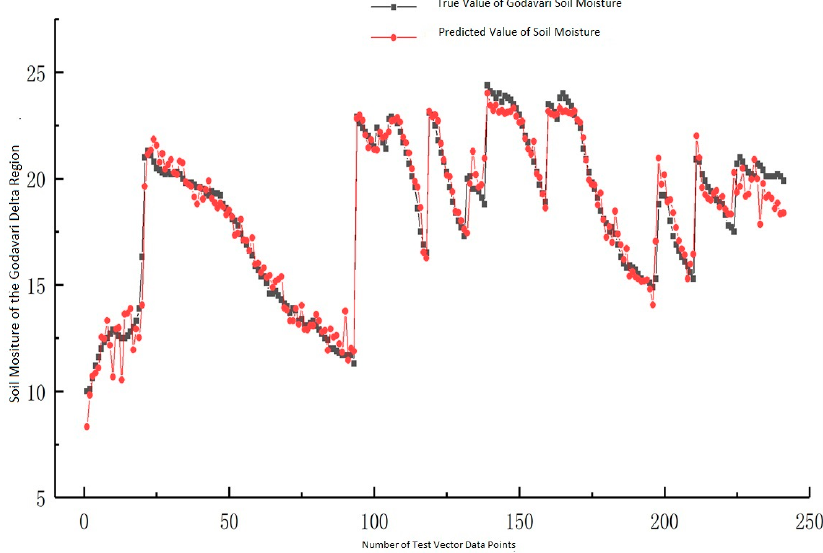
Figure 9. Forecast of training data—Godavari soil Moisture Dataset.